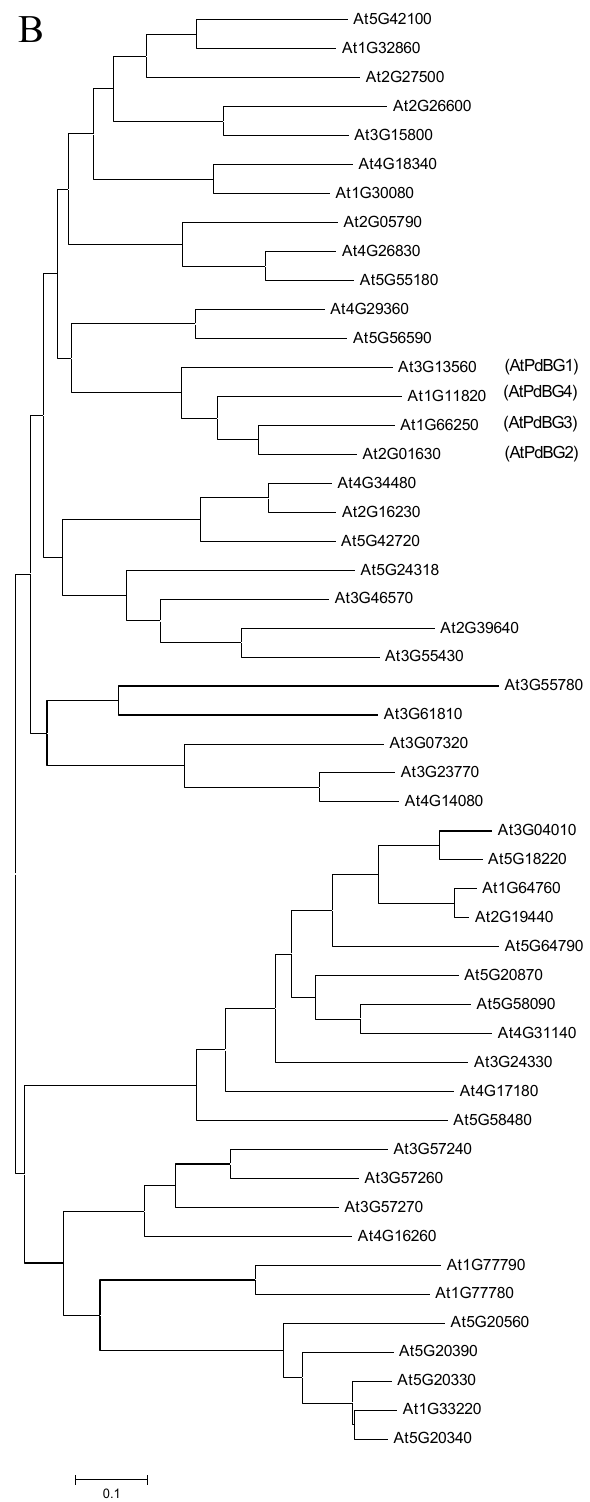
Figure 1. Sequence alignment and phylogenetic analysis. ( A ) Sequence similarity of β -1,3-glucanases among Arabidopsis thaliana BG family members Dark blue indicates that the homology level is 100%, pink indicates that the homology level ≥ 75%, and blue indicates that the homology level ≥ 50%. ( B ) Phylogenetic analysis of β -1,3-glucanases based on the amino acid sequences of Arabidopsis thaliana BG family members. The scale bar represents genetic distance.